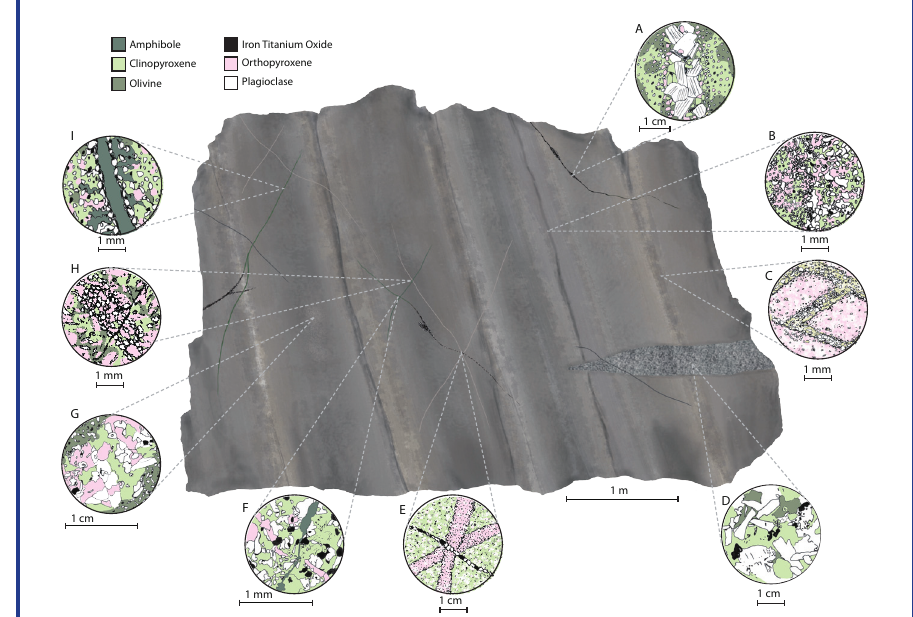
Figure 7. Sketch of a hypothetical outcrop in a future Site 1256 ophiolite of the dike-gabbro transition